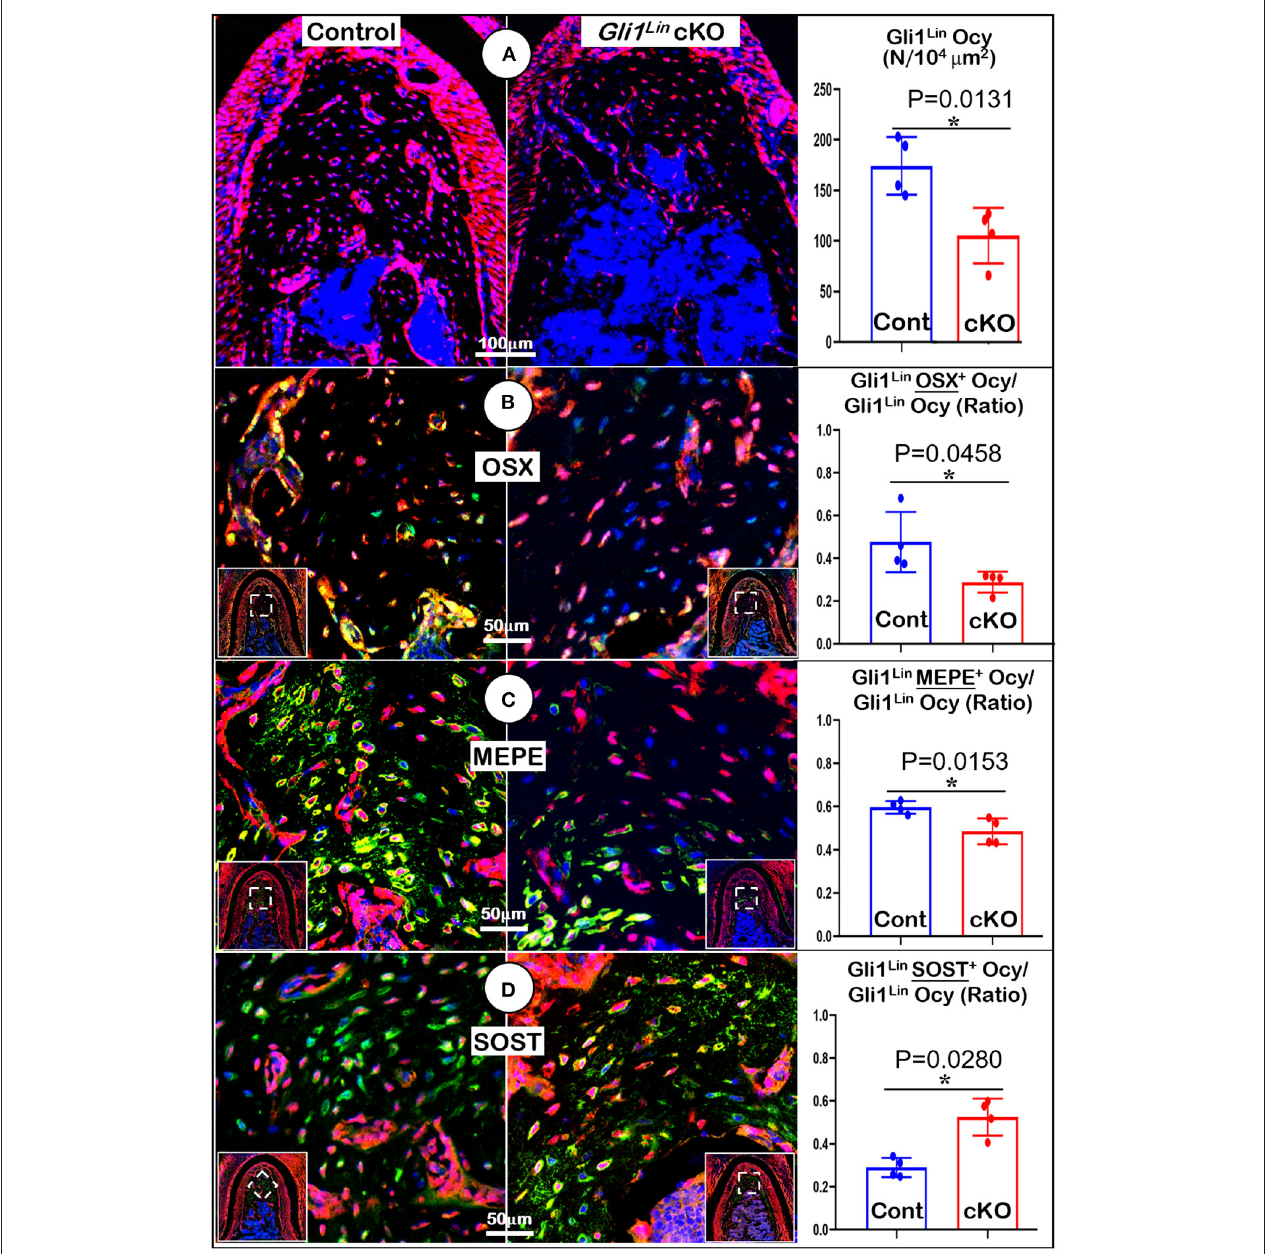
FIGURE 3 | Molecular analyses of mandibles from Gli1 Lin Tgf β r2 conditional knockout (cKO) mice (A) The confocal images revealed a great reduction in bone volume and number of Gli1 lin Ocy in cKO alveolar bone, which is statistically significant from the control ( right panel ); (B) The OSX immunostaining images showed a significant decrease in the raito of OSX + -Gli1 Lin Ocy to the total Gli1 lin Ocy; (C ) The confocal images of MEPE immunostainings showed a significant reduction in the raito of MEPE + -Gli1 Lin Ocy to the total Gli1 lin Ocy in the cKO alveolar bone ( right panel ); (D) The confocal images of SOST immunostainings showed an increase in the raito of SOST + -Gli1 Lin Ocy to the total Gli1 Lin Ocy in the cKO alveolar bone, which was statistically significant from the control ( right panel ). n = 4. * P < 0.05 ; Ocy,